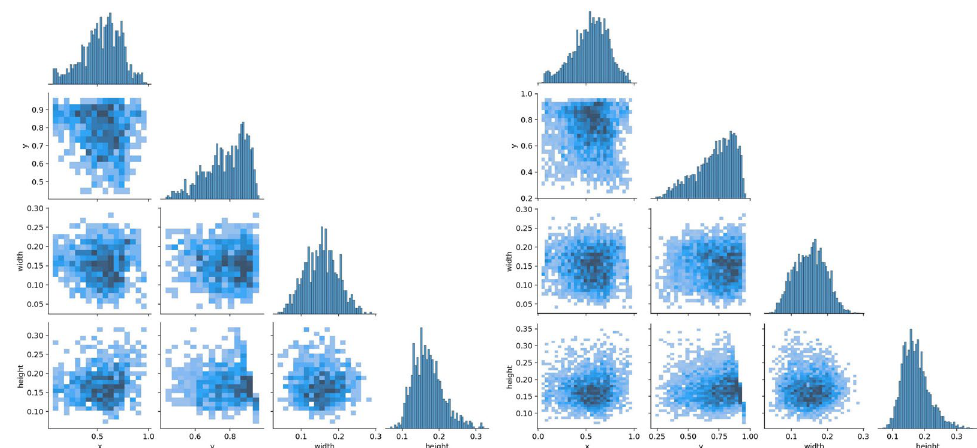
Figure 16. Distribution maps of 500 datasets and 2912 datasets. According to the fish position (x, y) and the fish’s body length (width, height) distribution, it was judged that there was no significant difference in the datasets. They all follow a normal distribution.